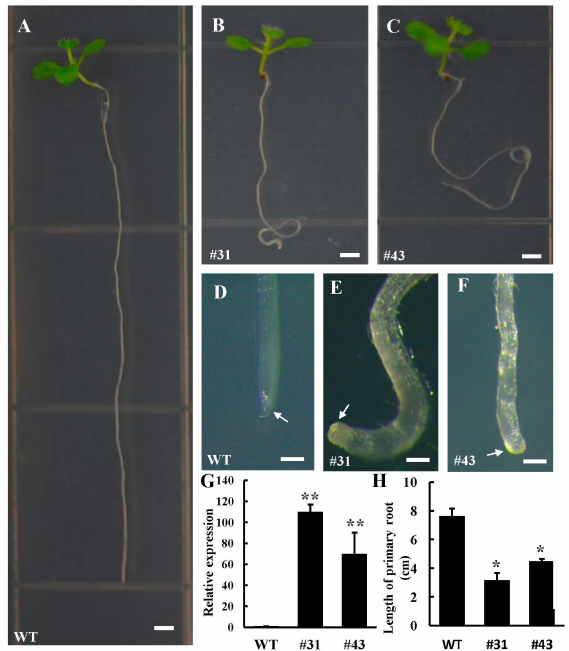
Figure 3. Reduced root length and changed morphology by overexpression of PtoWUSa in Arabidopsis . ( A – C ) two-week-old of WT ( A ) and PtoWUSa -overexpressing Arabidopsis plants including two independent transgenic lines of #31 ( B ) and #43 ( C ). ( D – F ) The primary root of WT ( D ) and two transgenic lines ( E , F ). Arrows pointed to primary root tip. ( G ) Transcription levels of PtoWUSa in transgenic plants. AtACTIN was used as a reference gene. The expression level in WT was set to 1. ( H ) The length of root of WT and transgenic plants. * and ** indicated the di ff erence between WT and each transgenic line at p < 0.05 and p < 0.01 levels, respectively. Scale bars: ( A–C ) = 0.2 cm; ( D – F ) = 200 µ